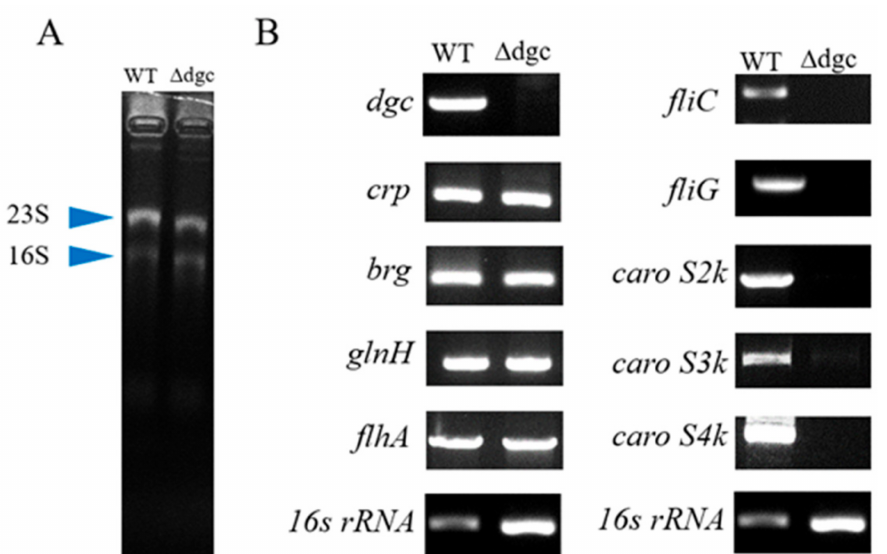
Figure 3. Transcriptional analysis of bacteriocin genes and regulatory genes by two-step endpoint RT- PCR. ( A ) 16s RNA expression of the wild-type 89-H-rif-12 and the dgc defective mutant. ( B ) Shown are gel electropherogram of RT-PCR products exhibited by the wild-type and dgc defective mutants. 2.5. Extracellular L-Glutamine Concentrations Have Varied Effects on